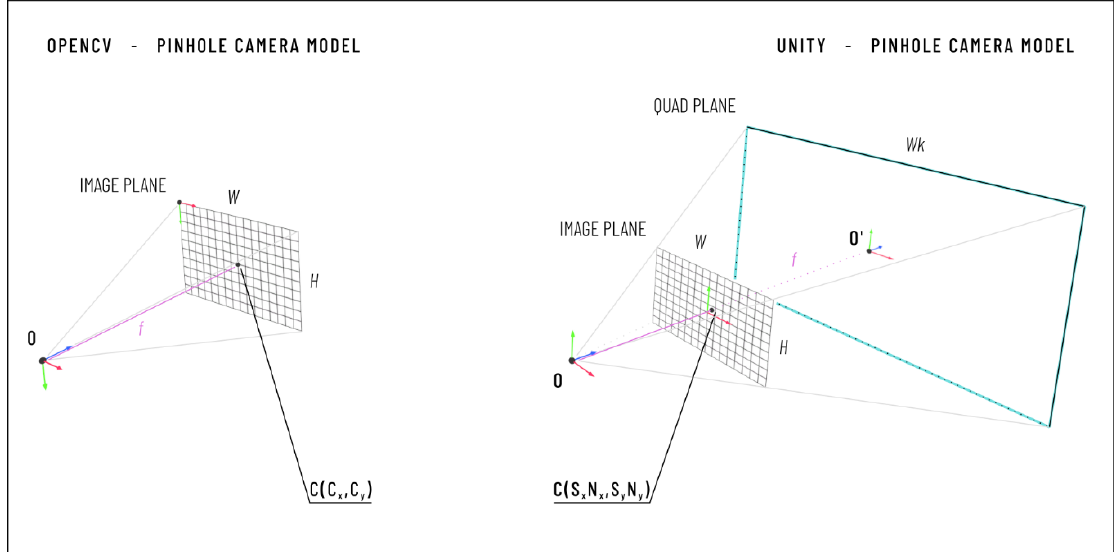
Figure 4. Camera coordinate frame and image coordinate frame of the pinhole camera model in OpenCV and in Unity. Both OpenCV and Unity assume that the camera principal axis is aligned with the positive Z -axis of the camera coordinate system, but the OpenCV coordinate system is right-handed (the Y -axis is oriented downward) while the Unity coordinate system is left-handed (the Y -axis is oriented upward). Moreover, in OpenCV, the origin of the image coordinate system is the center of the upper-left image pixel while in Unity the origin of the image coordinate system is at the image center. This picture also shows the coordinate system of the quad primitive used in Unity.